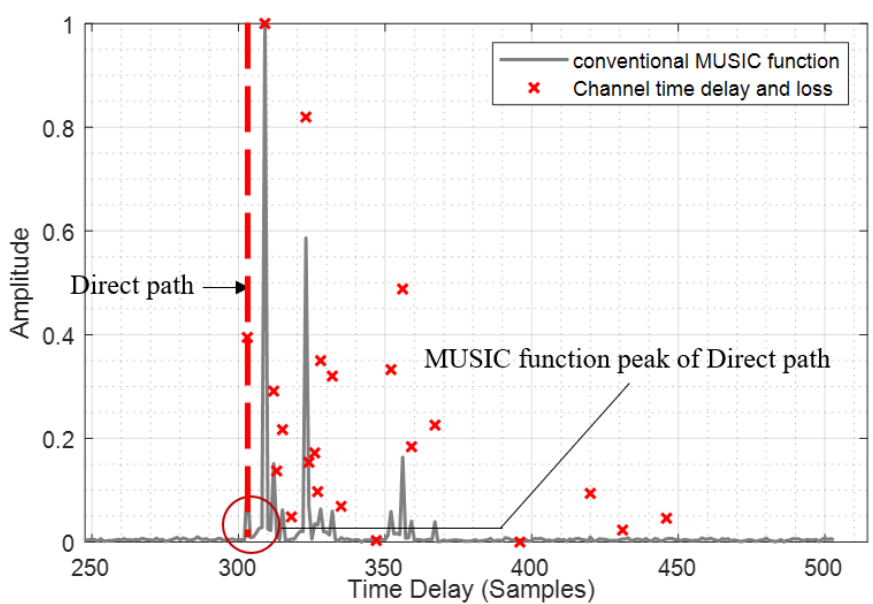
Figure 1. The conventional MUSIC spectral function in typical NLOS channel.